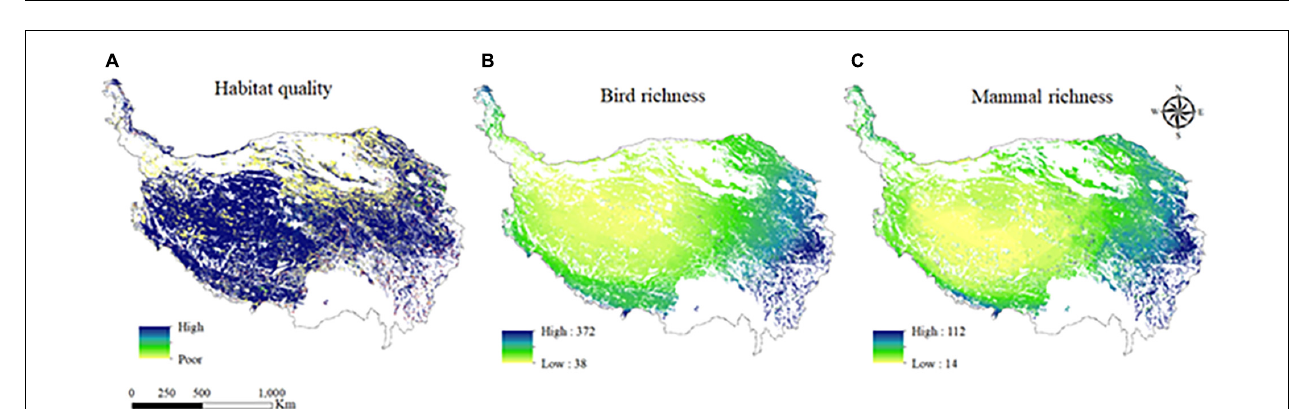
FIGURE 3 | The spatial distribution of habitat quality (A) ; bird species richness (B) ; and mammal richness (C) in the grazing regions on the Qinghai-Tibet Plateau